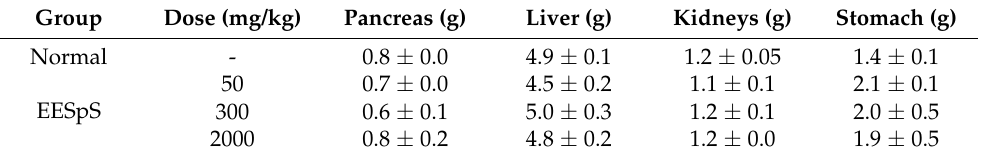
Table 1. Effect of the acute administration of ethanolic extract of the stems obtained from S. polystachya on the body weight and relative organ weight of normal female mice.